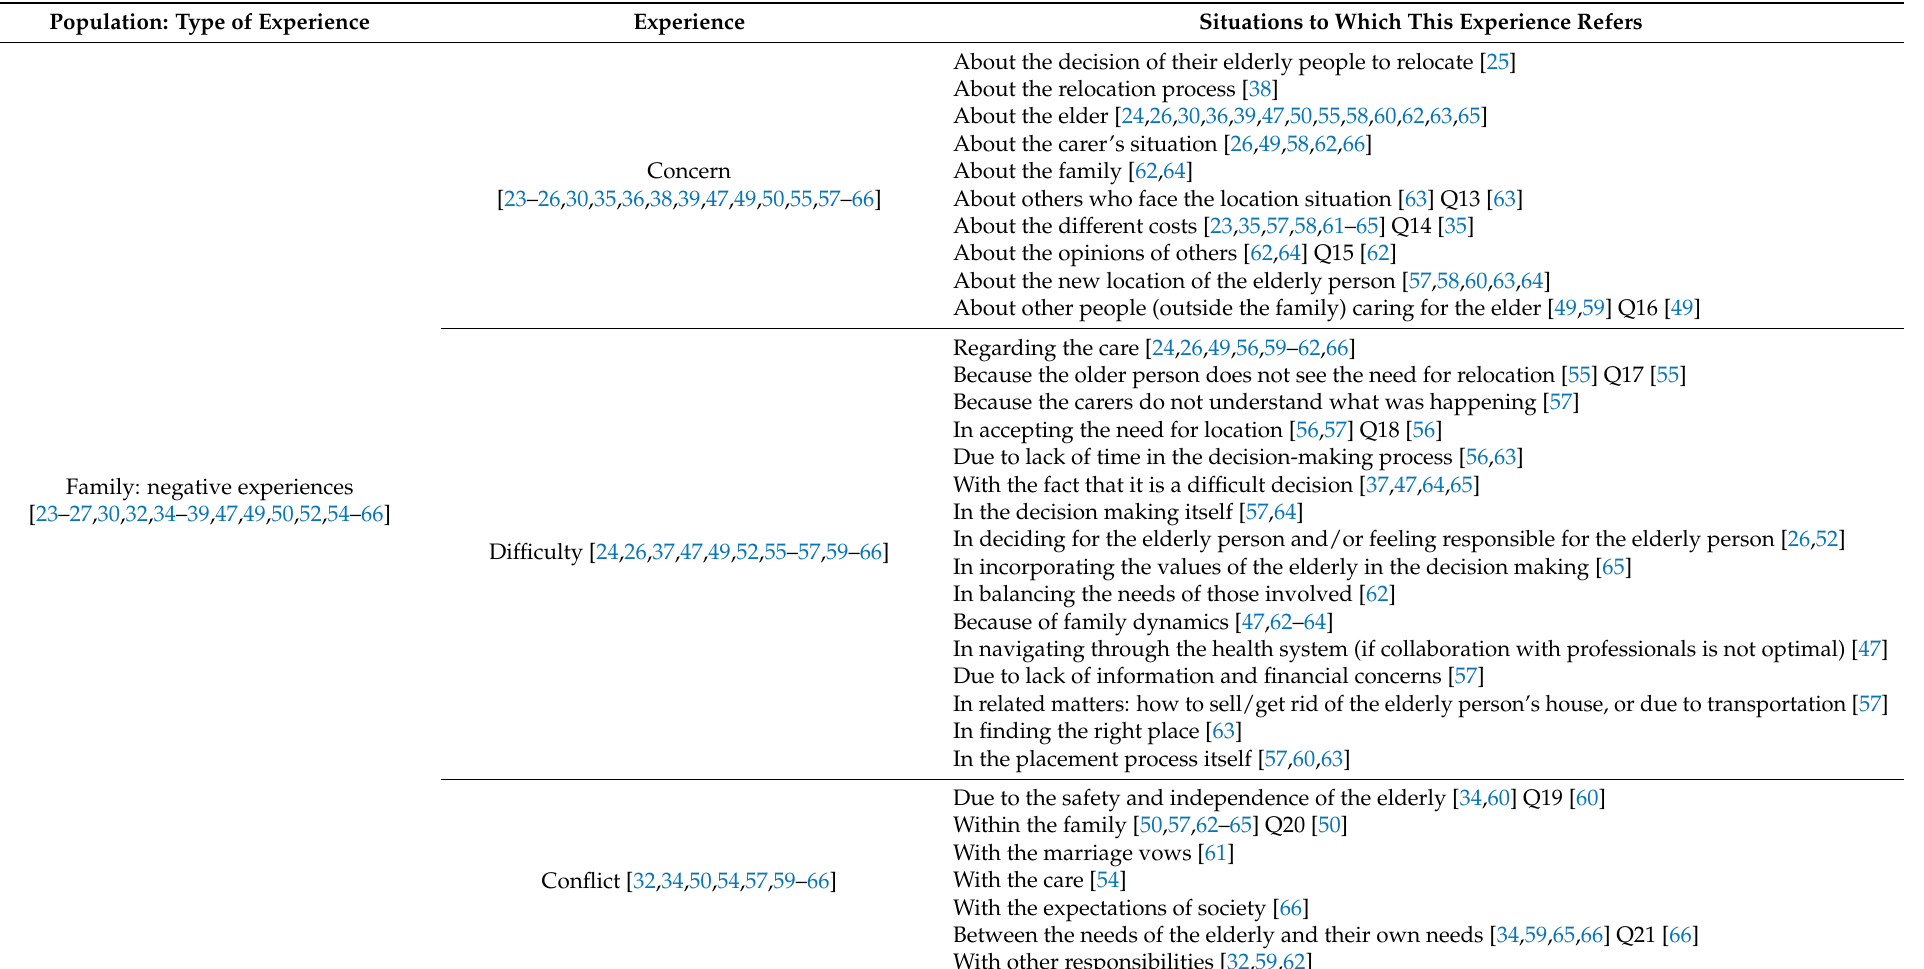
Table 4. Relevant negative experiences of family members a